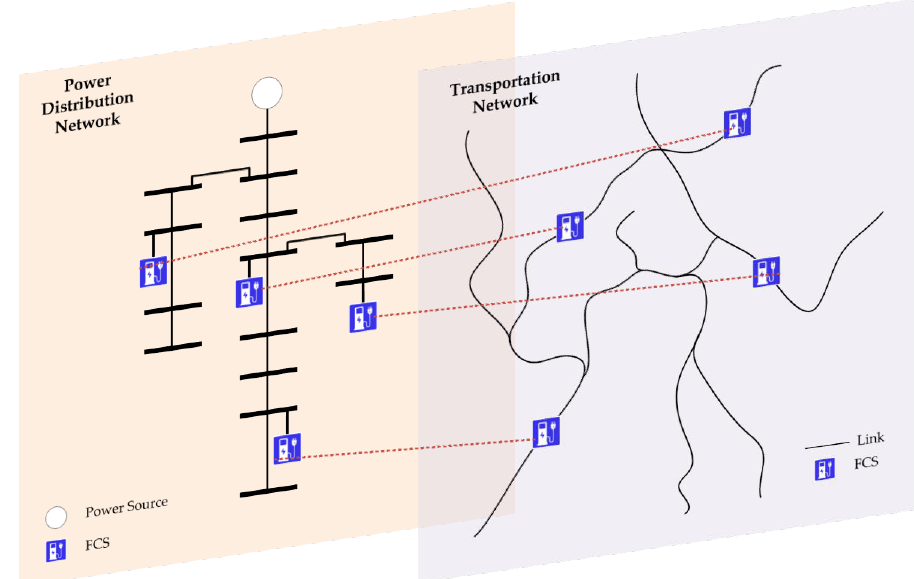
Figure 1. Conceptual of the coordination of TN and PDN.